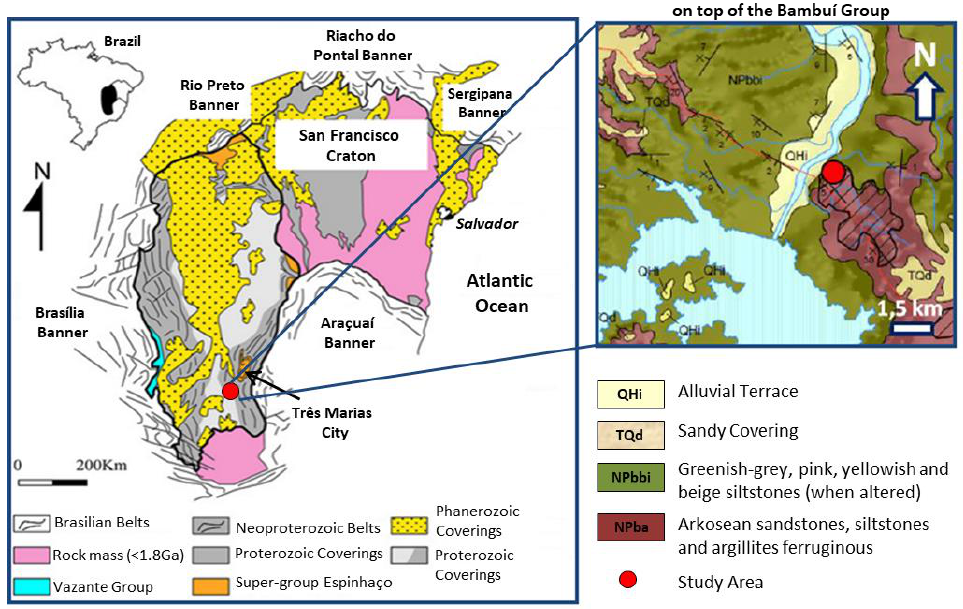
Figure 2. Geological setting of the study area in the San Francisco Craton. Adapted from [15].